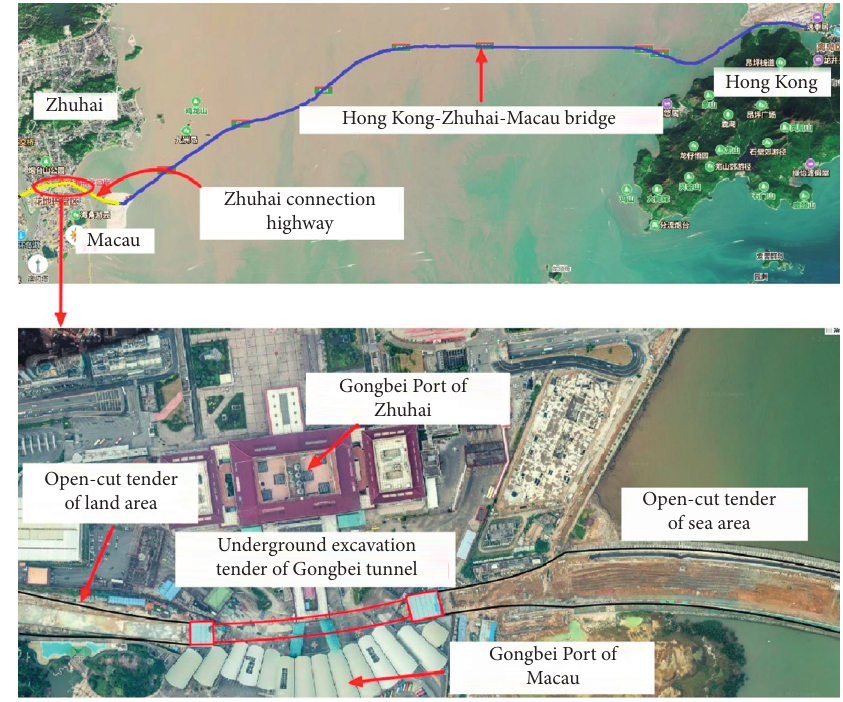
Figure 1: Location plan of the Gongbei tunnel.